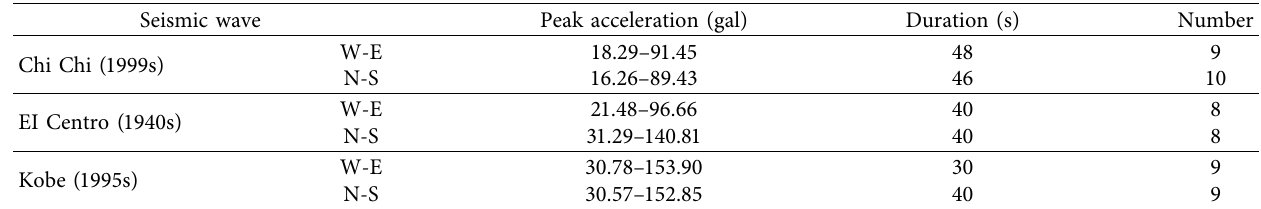
Figure 1: The lateral vibration experiment and single person swaying test. (a) Schematic of structure; (b) external excitation; (c) stand crowd swaying excitation; (d) seated crowd swaying excitation; (e) single person swaying. Table 1: Details of test seismic waves.